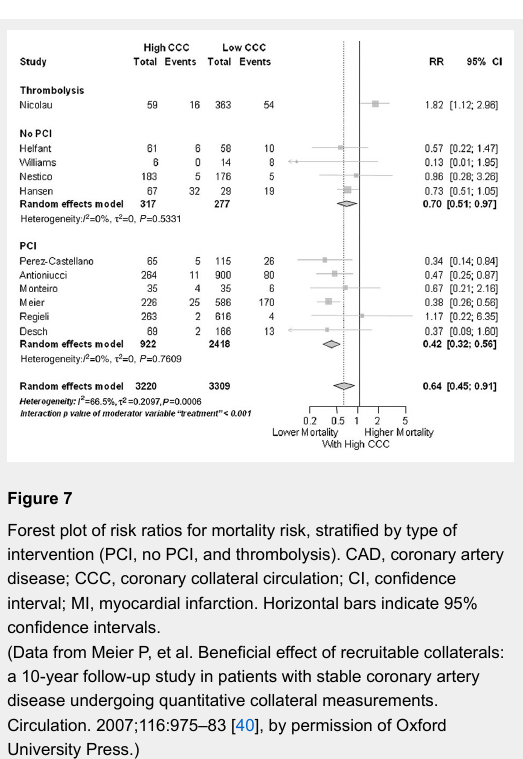
Completely normal left ventricular angiogram (top middle and right) due to extensive collateral supply of the proximally occluded left anterior descending artery via apical branch and septal collateral by the right coronary artery (bottom). Functional assessment is performed by balloon occlusion after recanalization of the chronic total occlusion (bottom right). (Data from Seiler C. Assessment and impact of the human coronary collateral circulation on myocardial ischemia and outcome. Circ Cardiovasc Interv. 2013;6:719–28 [86], with permission.)